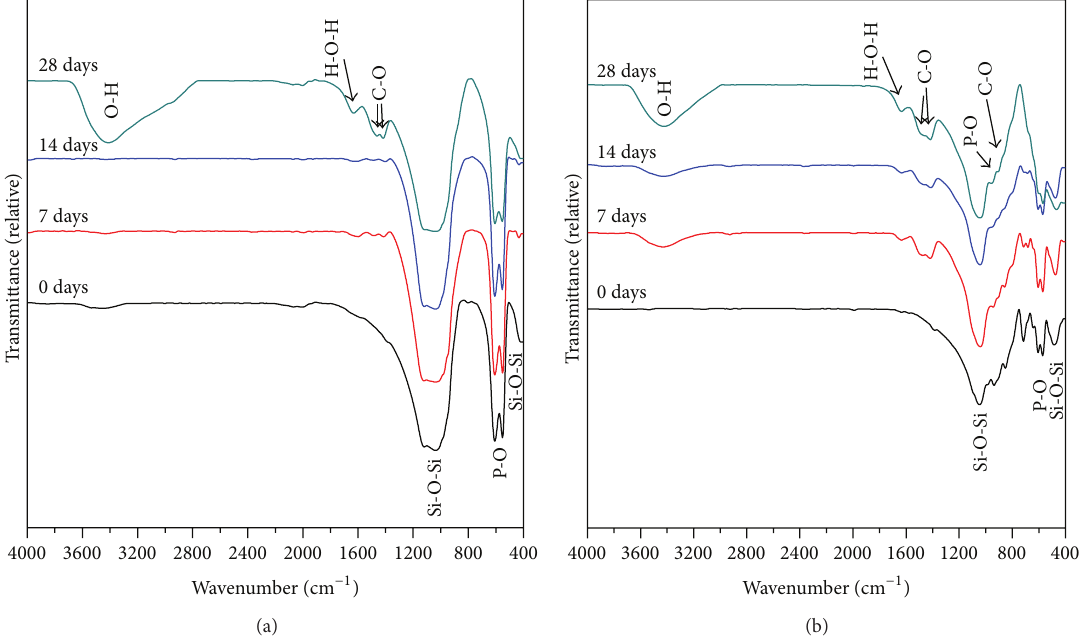
Figure 8: FTIR spectra of composites, (a) AW05 and (b) AW95, soaked in the SBF solution for various periods of